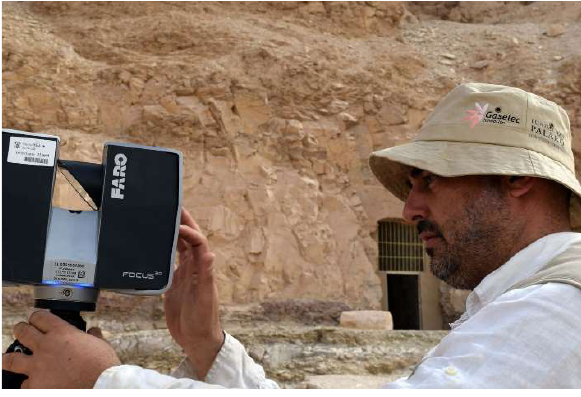
Figure 9. Configuring the laser options of the 3D scanner